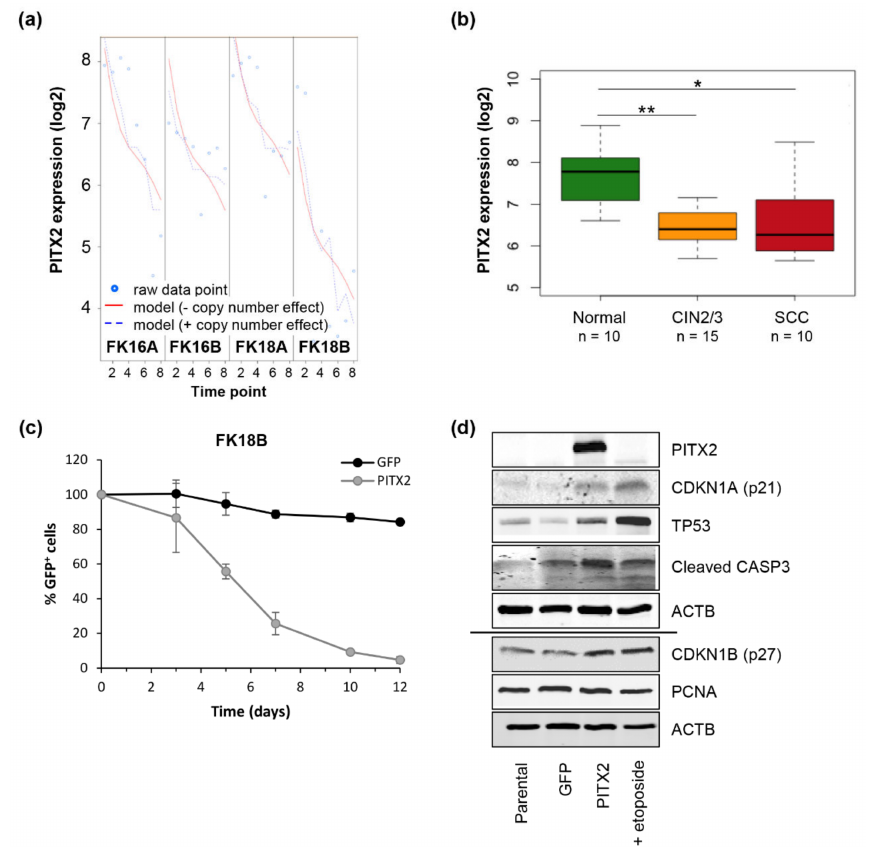
Figure 3. PITX2 acts as tumor suppressor in HPV-induced transformation. ( a ) PITX2 expression in HPV-transformed keratinocyte cell lines. Using our tigaR method, a model without (red continuous line) and with copy number e ff ect (blue discontinuous line) was fitted [17]. Similarity between the fitted models indicates that di ff erential PITX2 expression is not copy number-driven. ( b ) PITX2 expression in mRNA microarray data obtained from normal HPV-positive cervical epithelium (Normal), high-grade precancerous lesions (CIN2 / 3), and squamous cell carcinomas (SCC). Boxplots show medians with lower and upper quartiles, and range whiskers. * p < 0.05, ** p < 0.005, according to the Wilcoxon rank-sum test. ( c , d ) Late FK18B cells (ca. passage 190) were transduced with an empty LeGO-iG2 vector or a LeGO-iG2-PITX2 construct. ( c ) FACS analysis: Mean and standard deviation of two